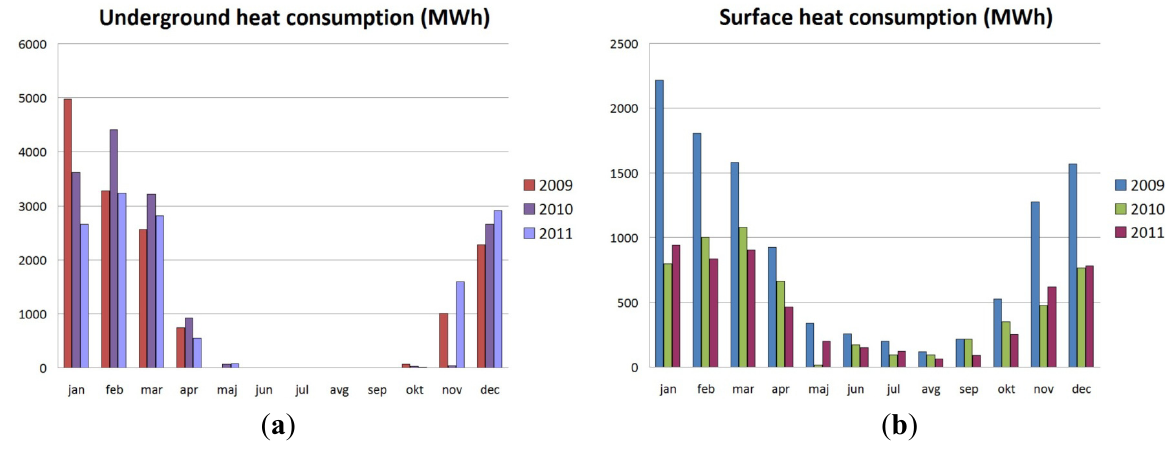
Figure 10. Heat consumption in years 2009 to 2011: ( a ) in underground mining processes; ( b ) on surface